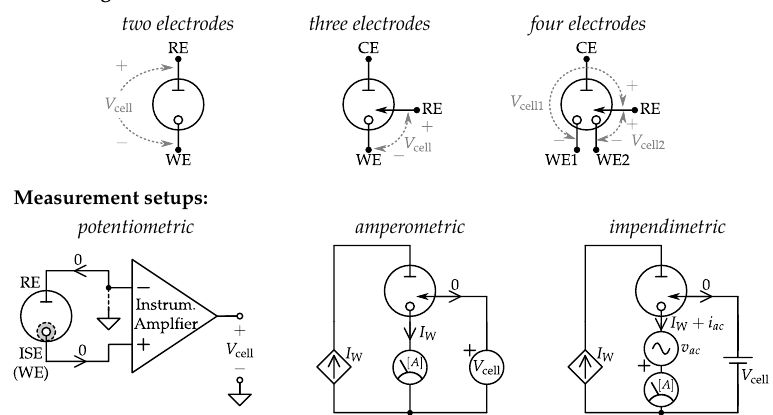
Figure 2. Electrochemical transducer cell typical configurations and measurement setups.